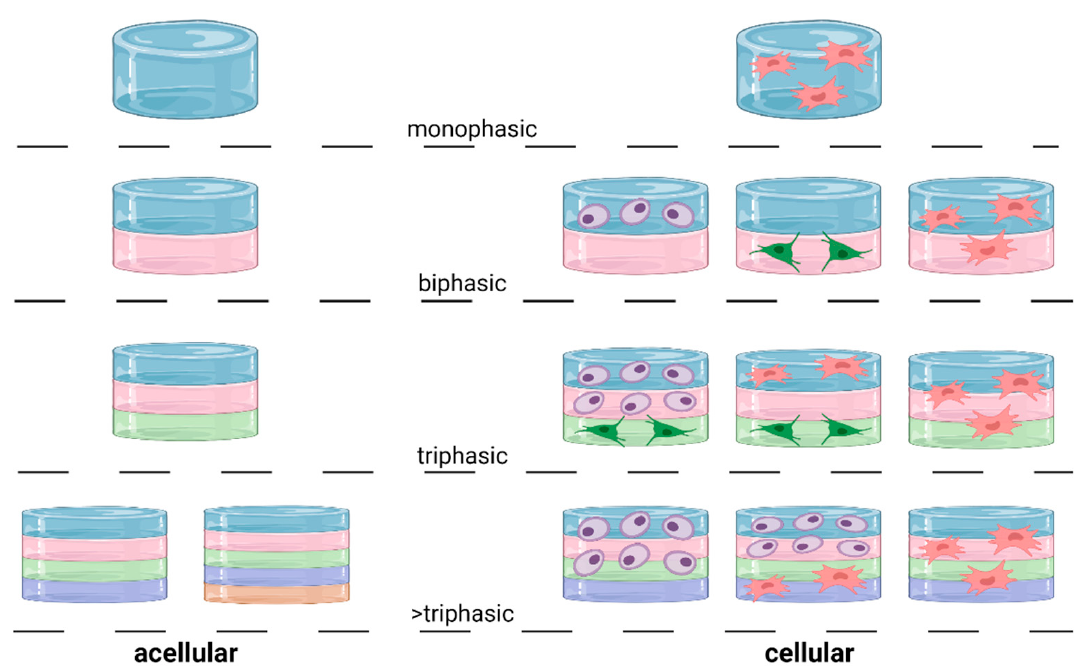
Figure 6. Design options for an OC scaffold. Categories include mono (one) phase, bi (two) phases, tri (three) phases and >tri (more than three phases). Any combination of number of phases, materials, and cell type can be used to create the ‘ideal’ OC scaffold. For example, chondrocytes (purple) are commonly used in the cartilage phase/s, osteoblasts (green) in the subchondral bone phase/s while MSCs (pink) are used throughout the whole OC scaffold. Figure created with BioRender.com (10 October 21).